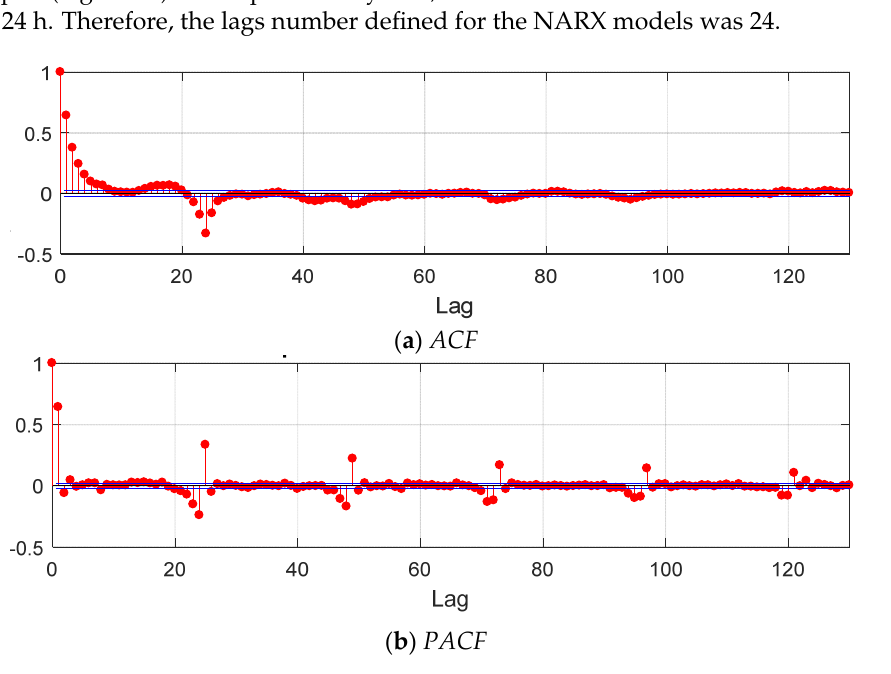
Table 4. Mechanical characteristics of the monocrystalline module ISF-250 [40].